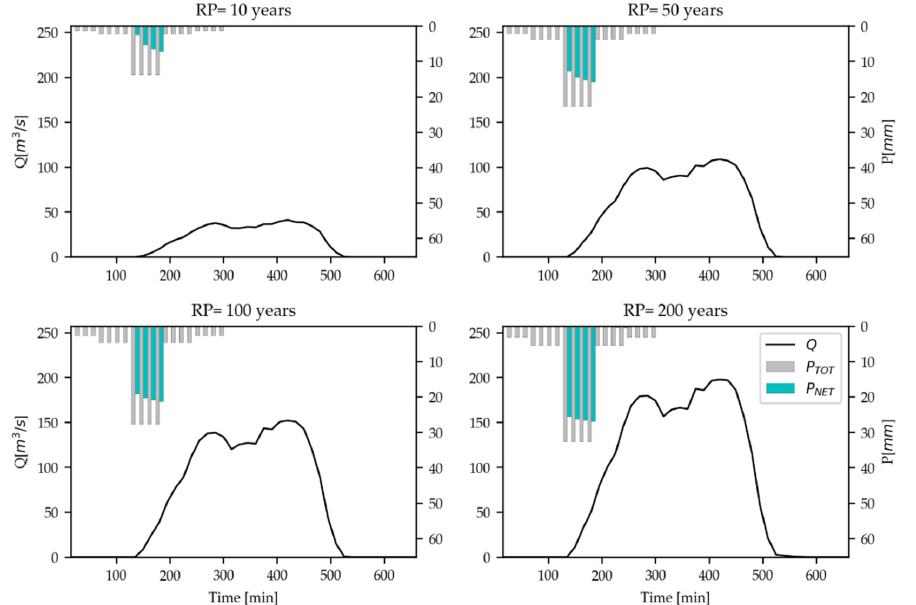
Figure 6. Gross Chicago hyetographs ( P TOT ) and excess rainfall hyetographs ( P NET ) (upper x-axis), and design hydrograph (Q-lower x-axis) for the selected return times (10, 50, 100, and 200 years).